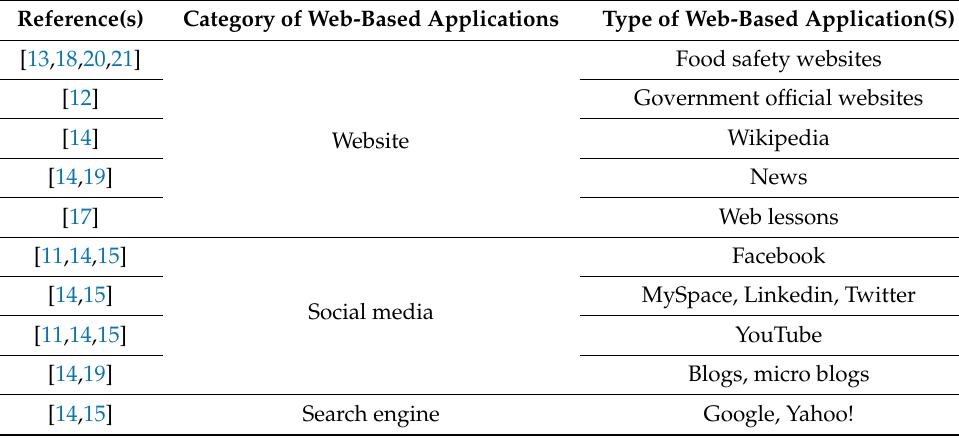
Table 4. Web-based applications used to access food safety